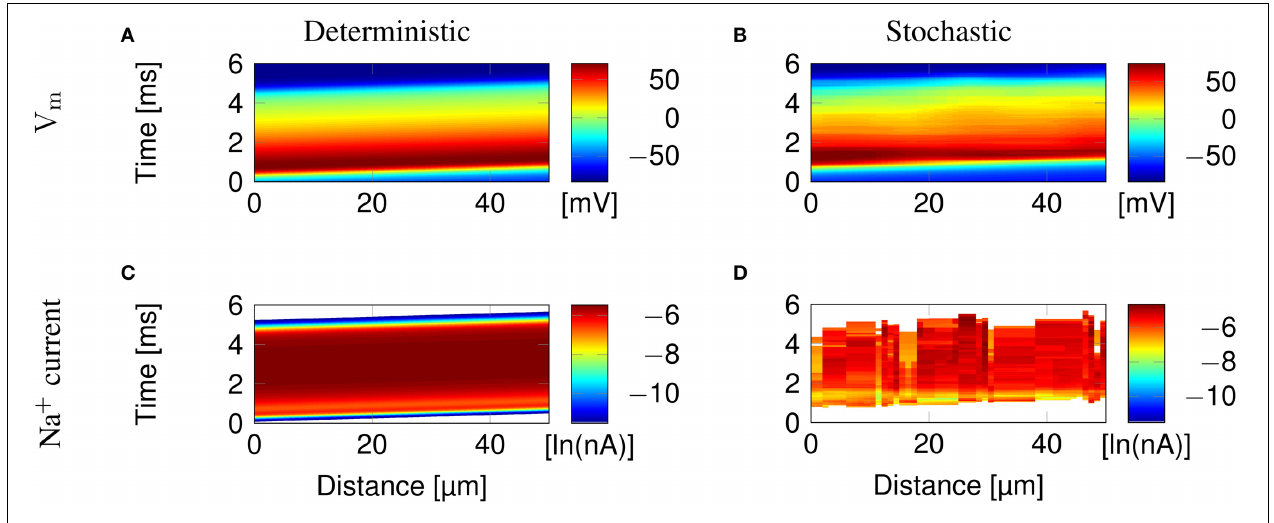
simulation. (B) The membrane potential and (D) Na + current in a single trial of stochastic simulations. White areas signify no current